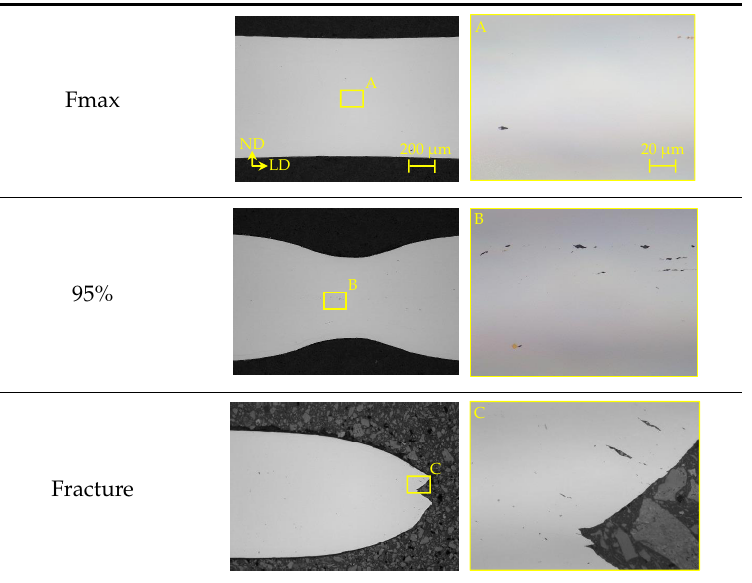
Table A16. Damage evolution of CP1000.